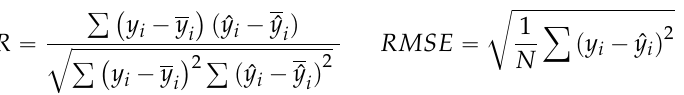
Table 1. Deviations between SSA trend and the S-curve method with the generated time series.